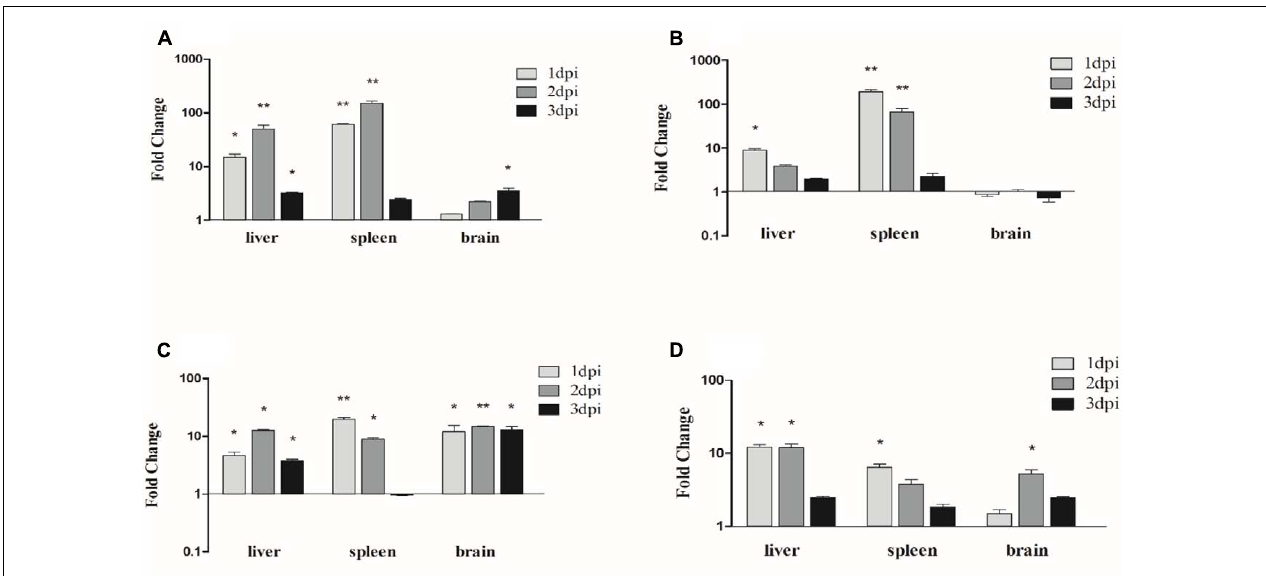
FIGURE 7 | Expression profiles of inflammatory cytokines in the APEC-infected ducks. (A) The expression profiles of IL-1 β in liver, spleen, and brain post-infection with APEC, (B) the expression profiles of IL-6, (C) the expression profiles of IL-8 and (D) the expression profiles of IL-10. The samples of APEC-infected and control ducks were collected at 1, 2, and 3 dpi. And the fold change was calculated by the experimental ducks vs. control ducks at the same time point, using the 2 − (cid:49)(cid:49) C T method. All data were expressed as means ± SD ( n = 3), and Student’s t -test was performed to evaluate the differences. ∗ Significant difference ( P < 0.05); ∗∗ highly significant difference ( P < 0.01); dpi, days post-infection.